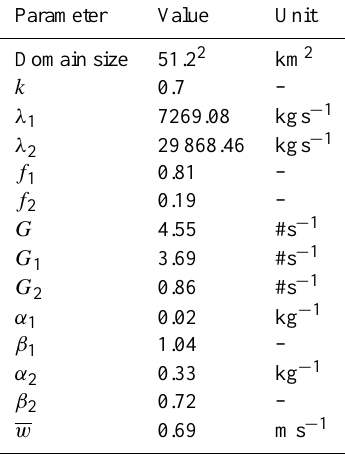
Table 3. Parameters for the model formulation with the two- component mixed Weibull